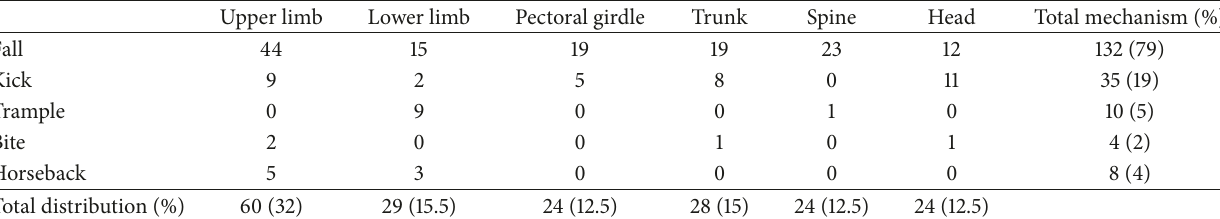
Table 2: Mechanism of injury and distribution.